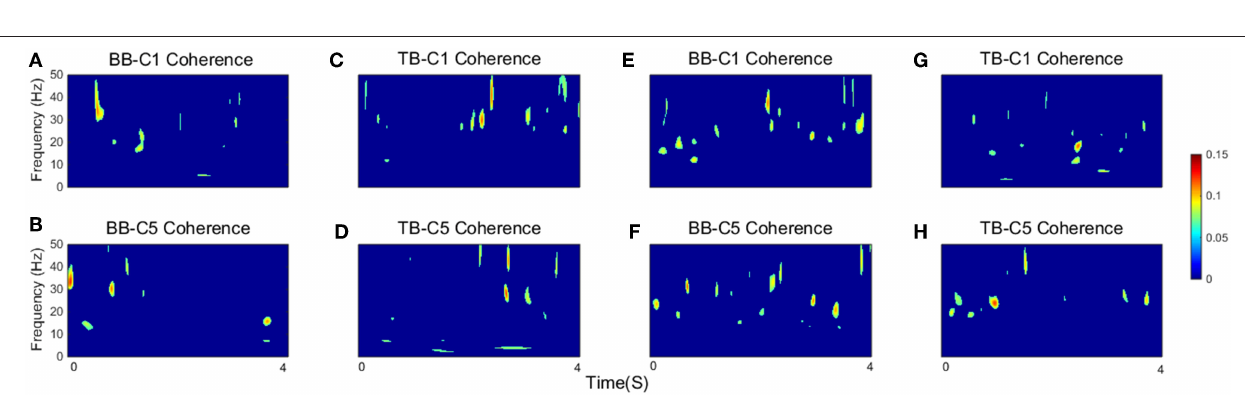
FIGURE 4 | The significant area of coherence between EEG signal from C1 and C5 and EMG signal from the BB and TB muscles of a representative participant. (A–D) show SCV for isokinetic movement, (E–H) show SCV for isometric exercise, respectively. Confidence level was 95%.